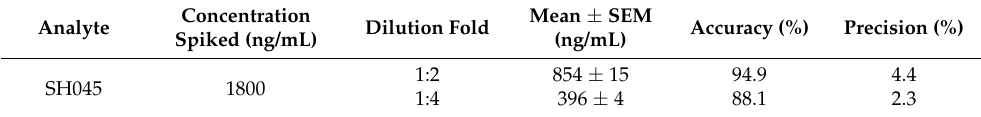
Table 5. Dilution integrity of SH045 in mice plasma ( n =